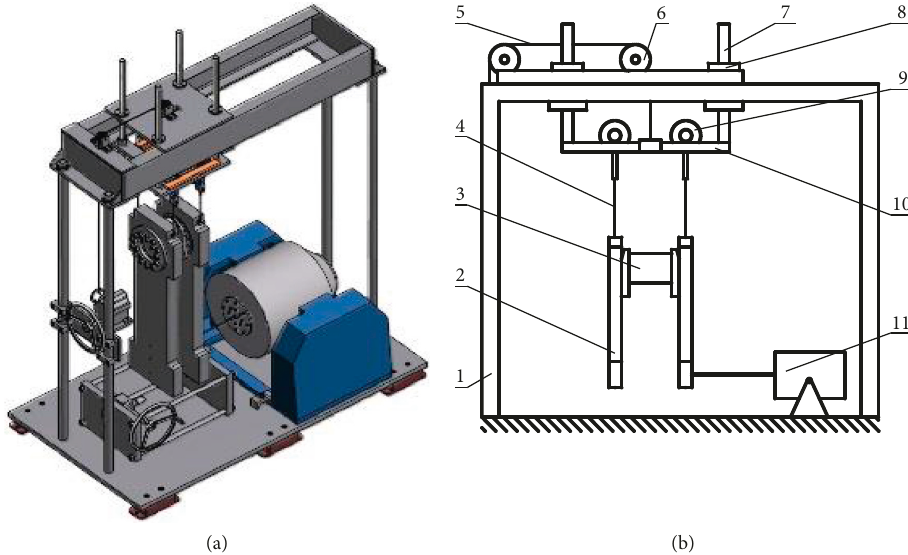
Figure 1: A testing machine of shaft bending fatigue. (a) Three-dimensional presentation, (b) two-dimensional schematic diagram. In (b), 1: machine rack, 2: pendulum block, 3: tested shaft, 4: suspending wirerope, 5: elevating wirerope, 6: elevating pulley, 7: suspending frame, 8: locking mechanism, 9: suspending roller, 10: suspending roller bed, 11: electromagnetic